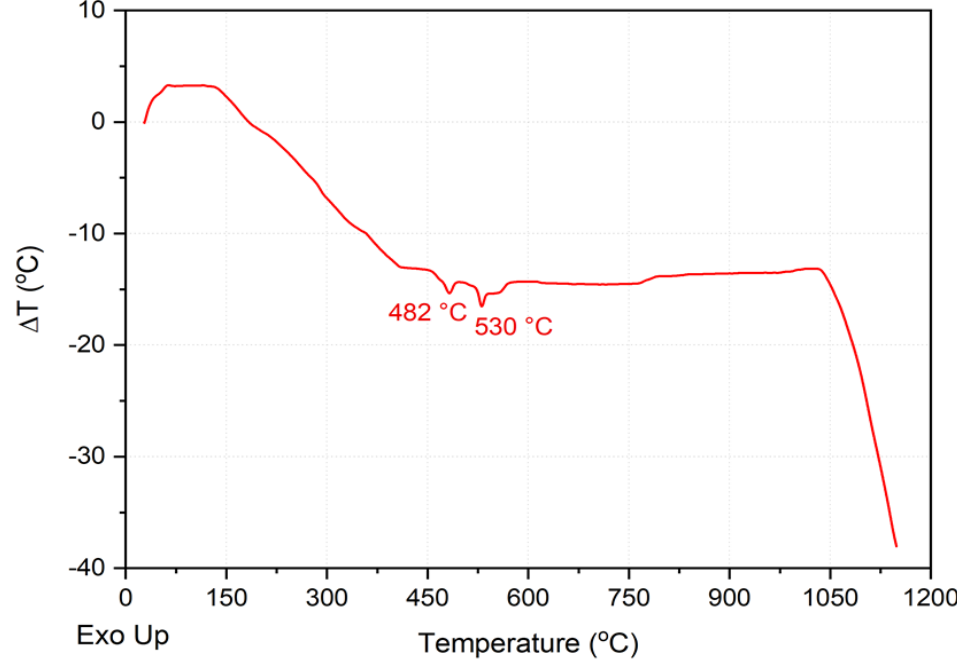
Figure 7. Result of morisca thermodifferential analysis.